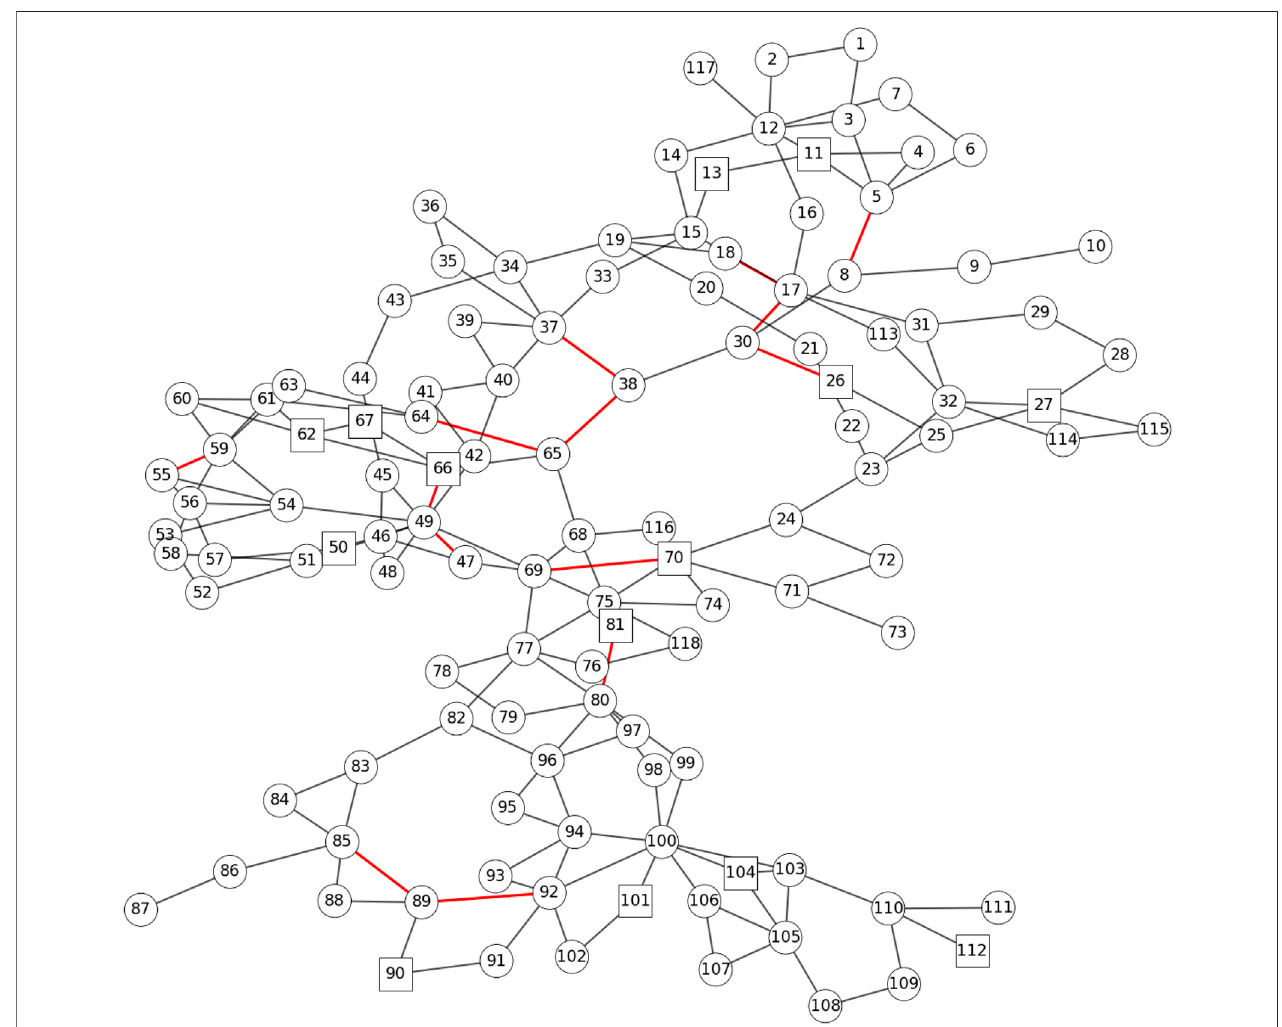
FIGURE 4 | The layout of IEEE 118-Bus Case. The red links represent the transmission bottlenecks.